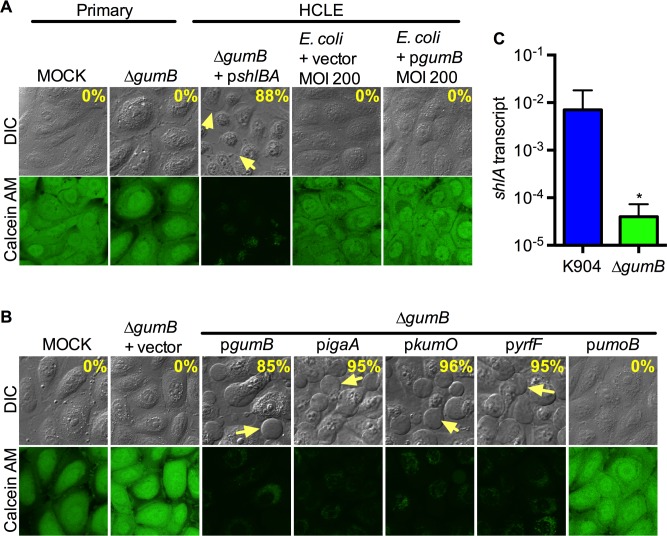
S. marcescens gumB gene is necessary but not sufficient for the bleb and cytotoxicity induction, and the gumB mutant strain defect is complemented by igaA-family genes and shlBA.(A,B) Confocal micrographs of primary human corneal and HCLE cells imaged with differential interference contrast (DIC) and calcein AM viability stain after exposure to bacteria for 2 h at MOI = 50, except where noted. Yellow arrows indicate blebs extending from corneal cells. (A) Confocal micrographs of HCLE cells with S. marcescens strain K904, mutant strains, or E. coli strain EC100D pir-116. Vector = pMQ132; pshlBA = pMQ541; pgumB = pMQ480. The percent of bleb positive cells induced by select bacteria are shown. (B) HCLE cells exposed to the gumB mutant strain (MOI = 50) with plasmid-borne igaA-family genes from S. marcescens (pgumB = pMQ480), S. enterica (pigaA = pMQ530), K. pneumoniae (pkumO = pMQ529), E. coli (pyrfF = pMQ531), or P. mirabilis (pumoB = pMQ600). Vector = pMQ132. (C) Relative gene expression using the ΔΔCT method depicts shlA transcript levels in the wild type (K904) and ΔgumB mutant strains at OD600 = 3; *p = 0.0286, Mann-Whitney test.